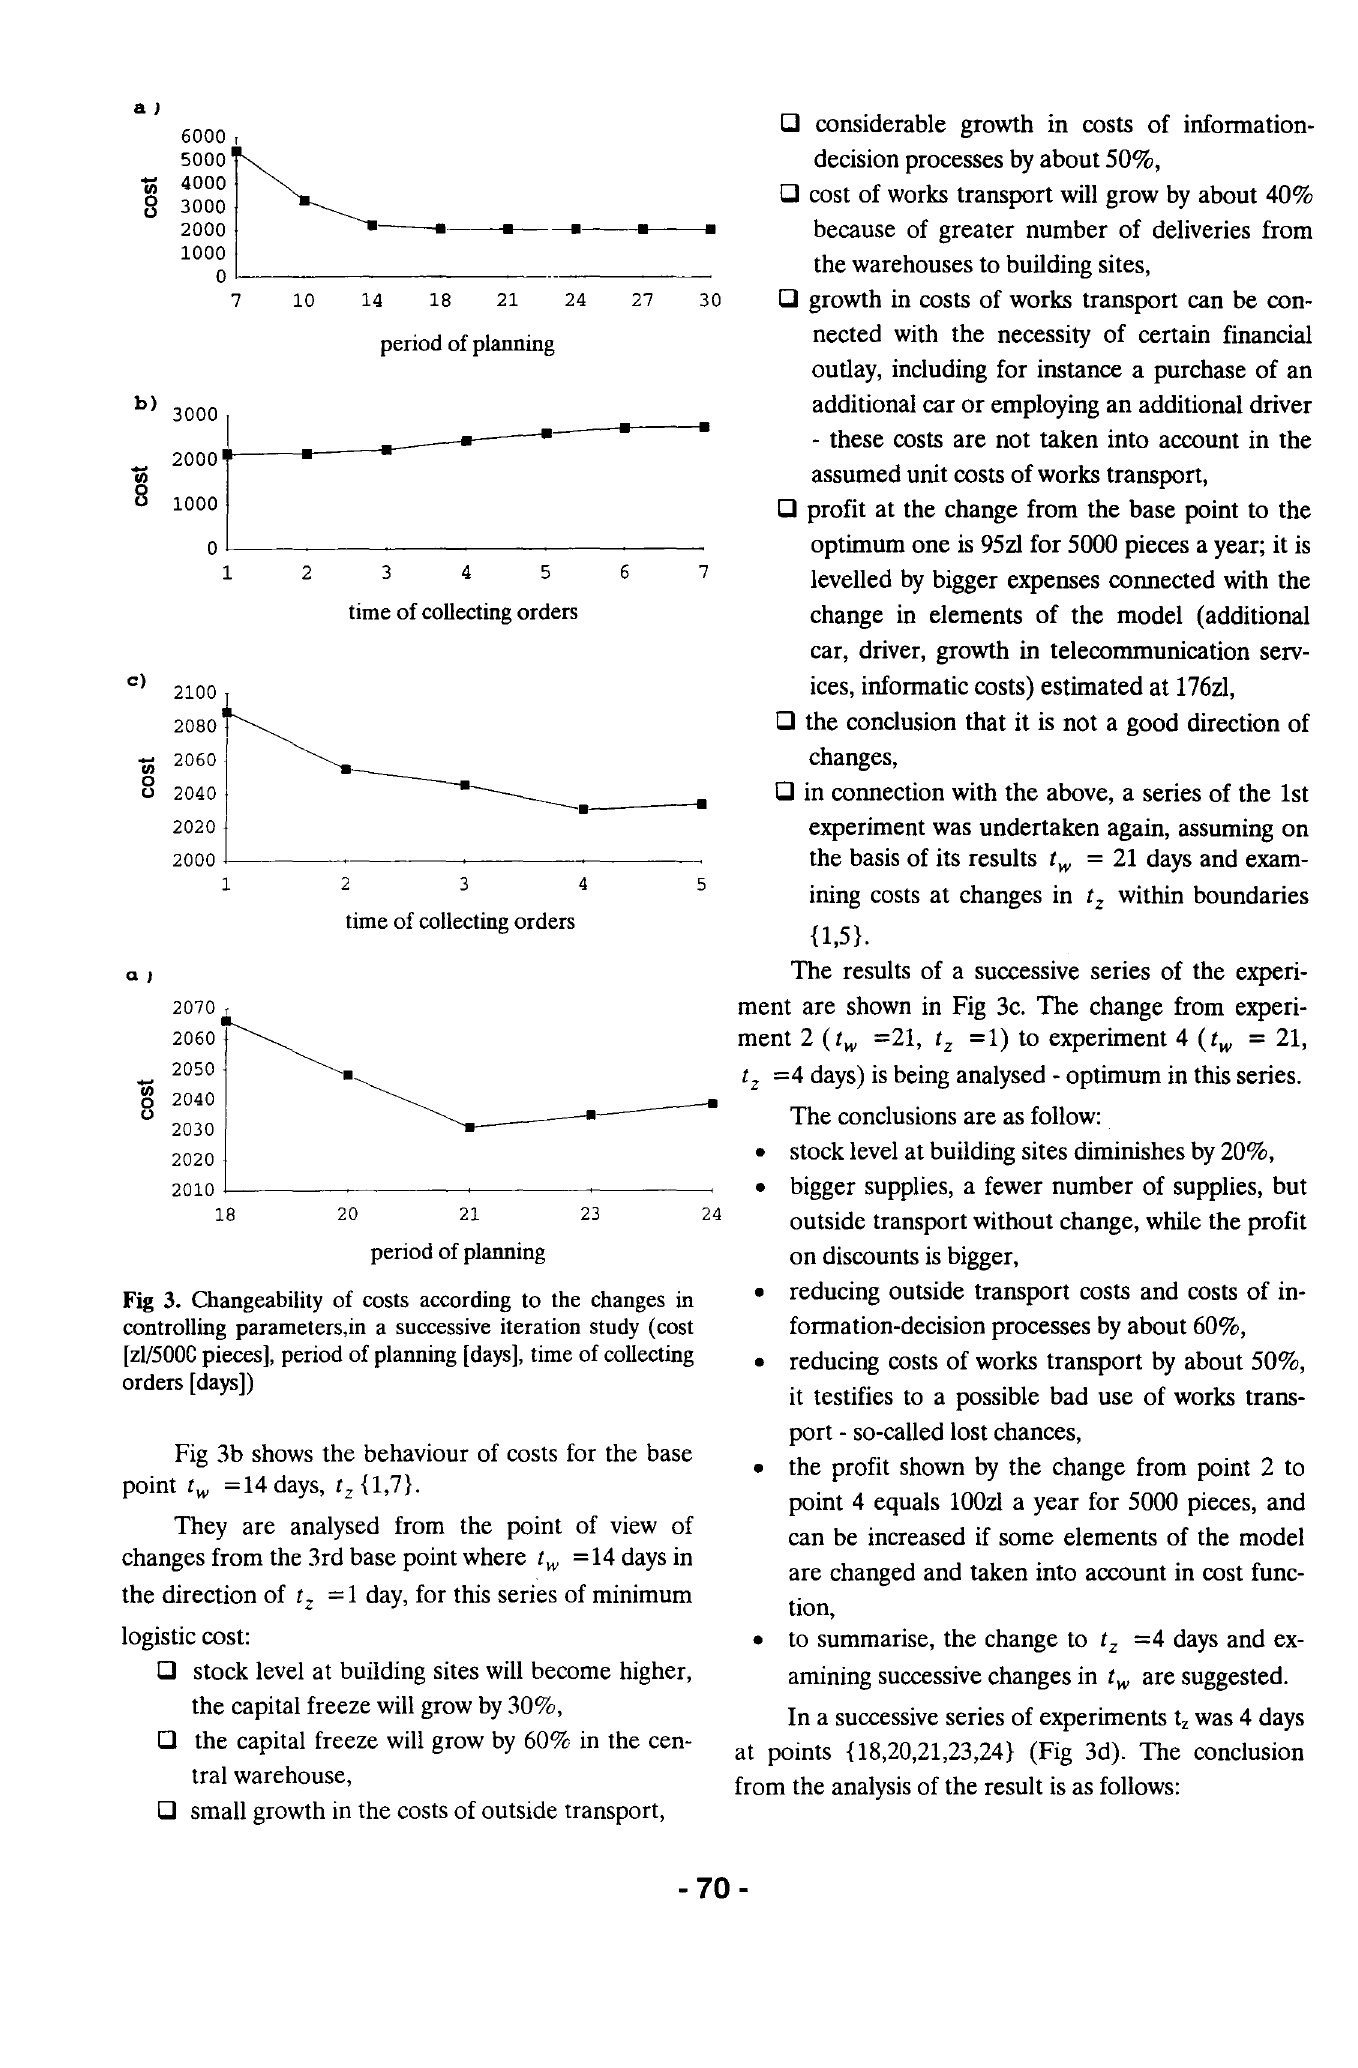
Fig 3. Changeability of costs according to the changes in controlling parameters,in a successive iteration study (cost [zl/500C pieces], period of planning [days], time of collecting orders